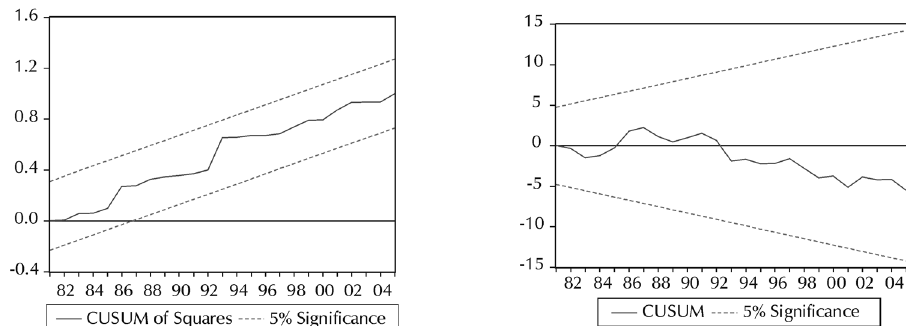
Plots of Cusum and Cusum of Squares for bank